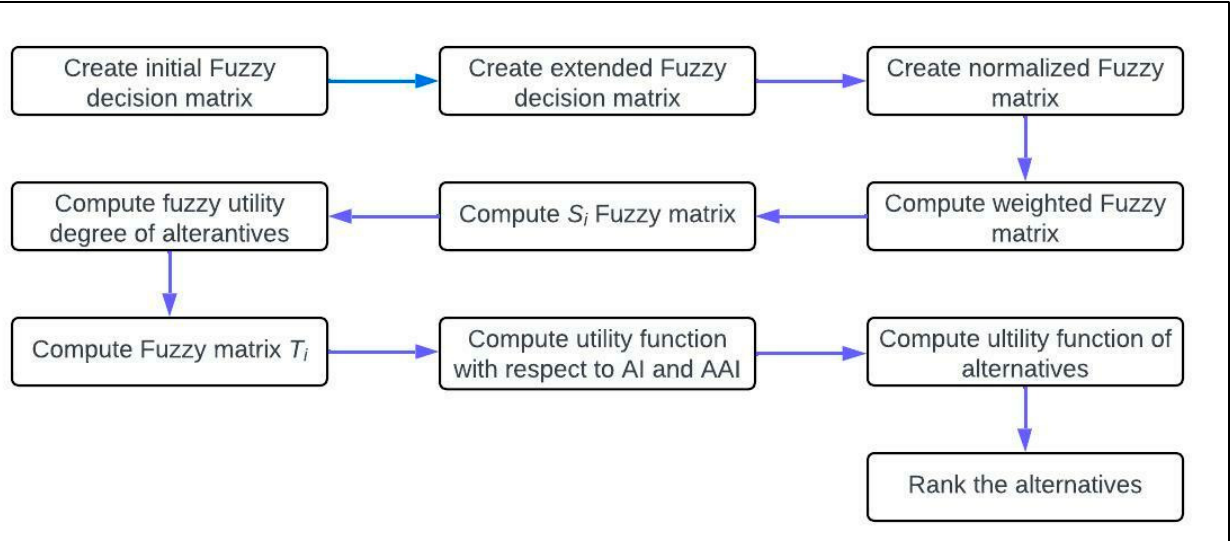
Table 1. Fuzzy scale used in the study.